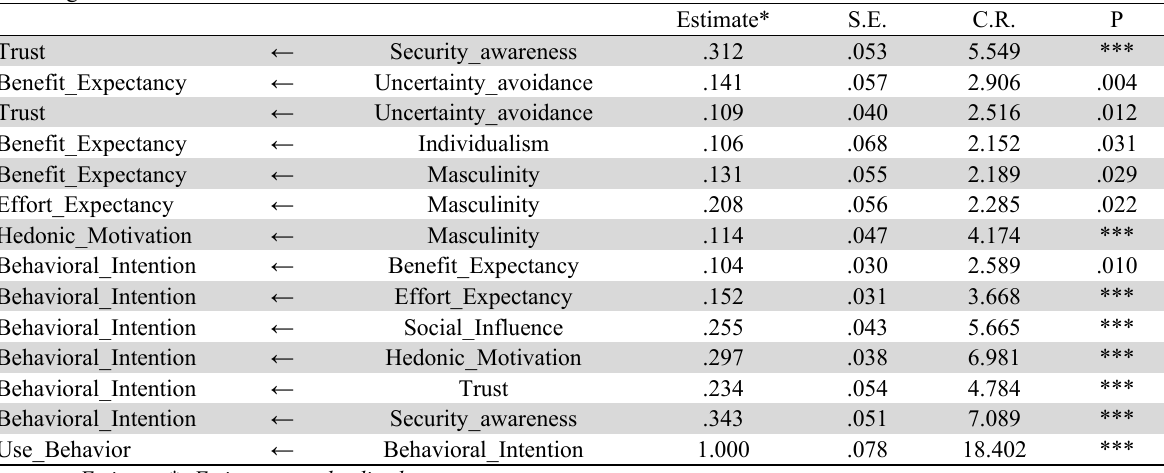
SEM regression model coefficients for the second time